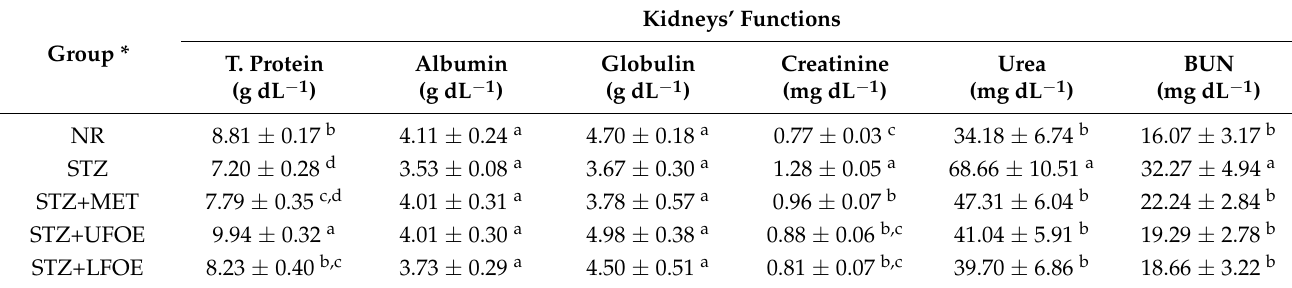
Table 7. Effect of orally administrated fermented oat extract on kidneys’ functions in Streptozotocin- induced diabetes in rats (mean ± SE), n =